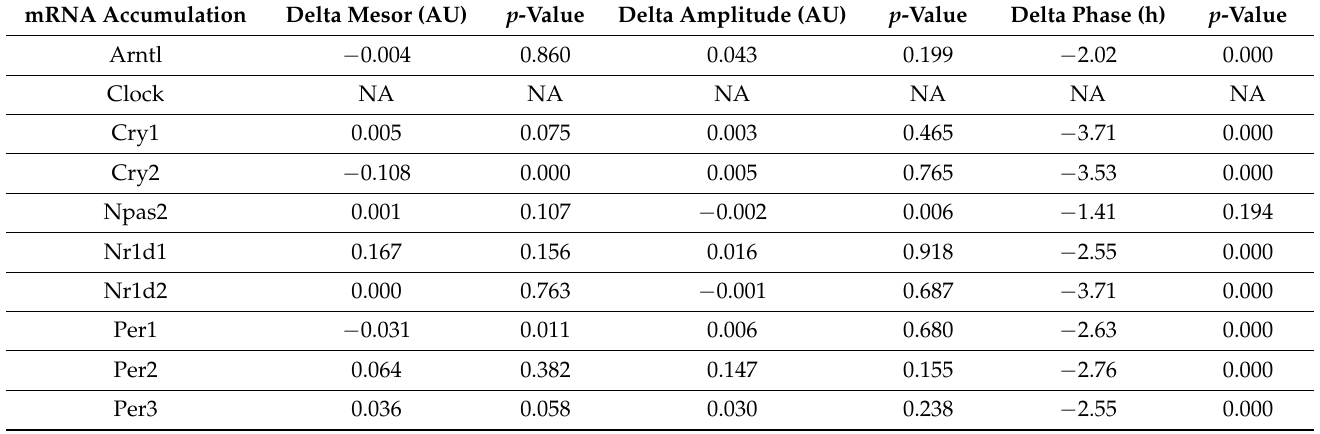
Table 1. The expression of clock genes was analyzed using Circacompare [31]. The following parameters were analyzed: mesor, amplitude, phase, and the related p -values. AU: arbitrary units. 0.000 indicates a p -value <